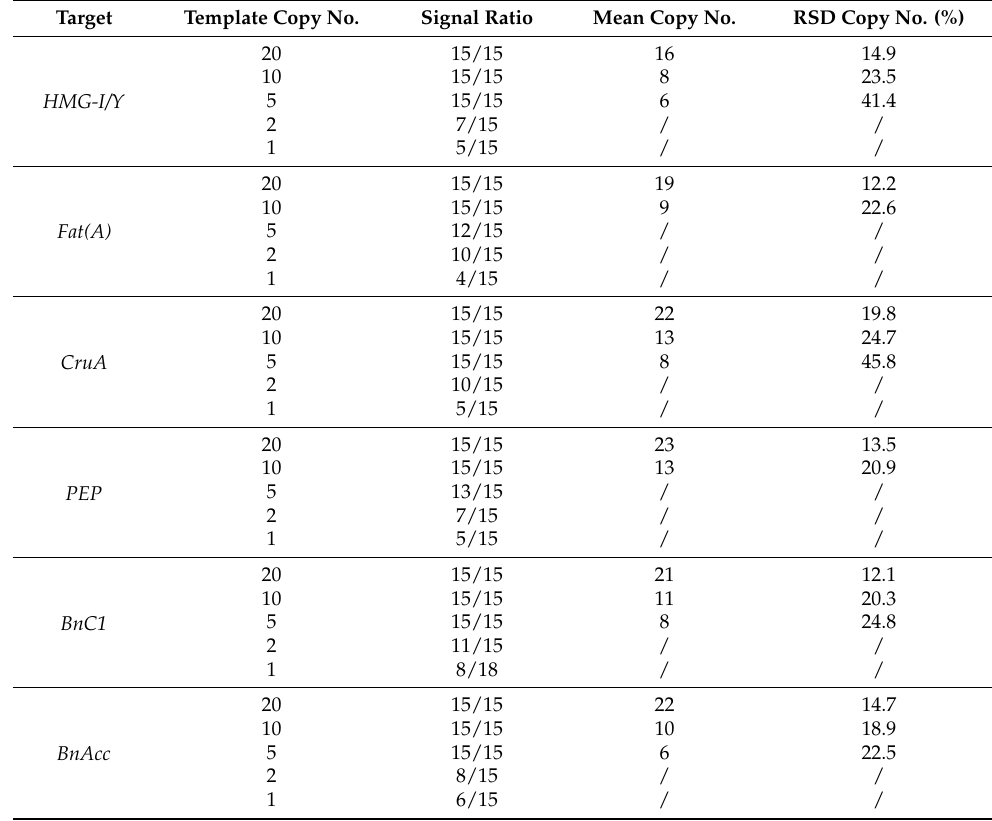
Table 4. aLOD and aLOQ of these six ERGs assays of Brassica napus. Target Template Copy No. Signal Ratio Mean Copy